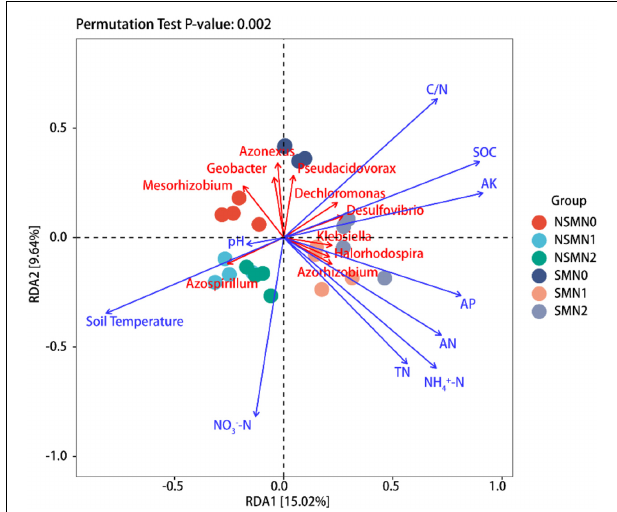
FIGURE 6 | Redundancy analysis (RDA) of the nifH community and soil environmental factors in the wheat rhizosphere. SOC, soil organic carbon; TN, total nitrogen; AN, available nitrogen; NH 4 + -N, ammonium nitrogen; NO 3 - -N, nitrate nitrogen; AP, available phosphorus; AK, available potassium; NSM,